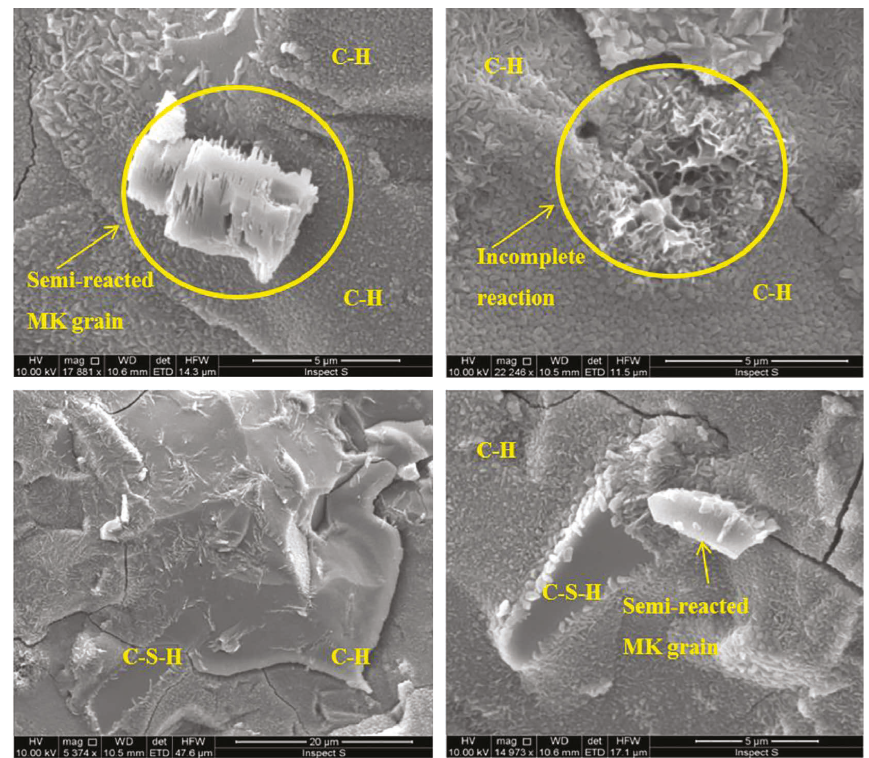
Figure 12: The SEM images for 95GMS geopolymer paste at 35 curing